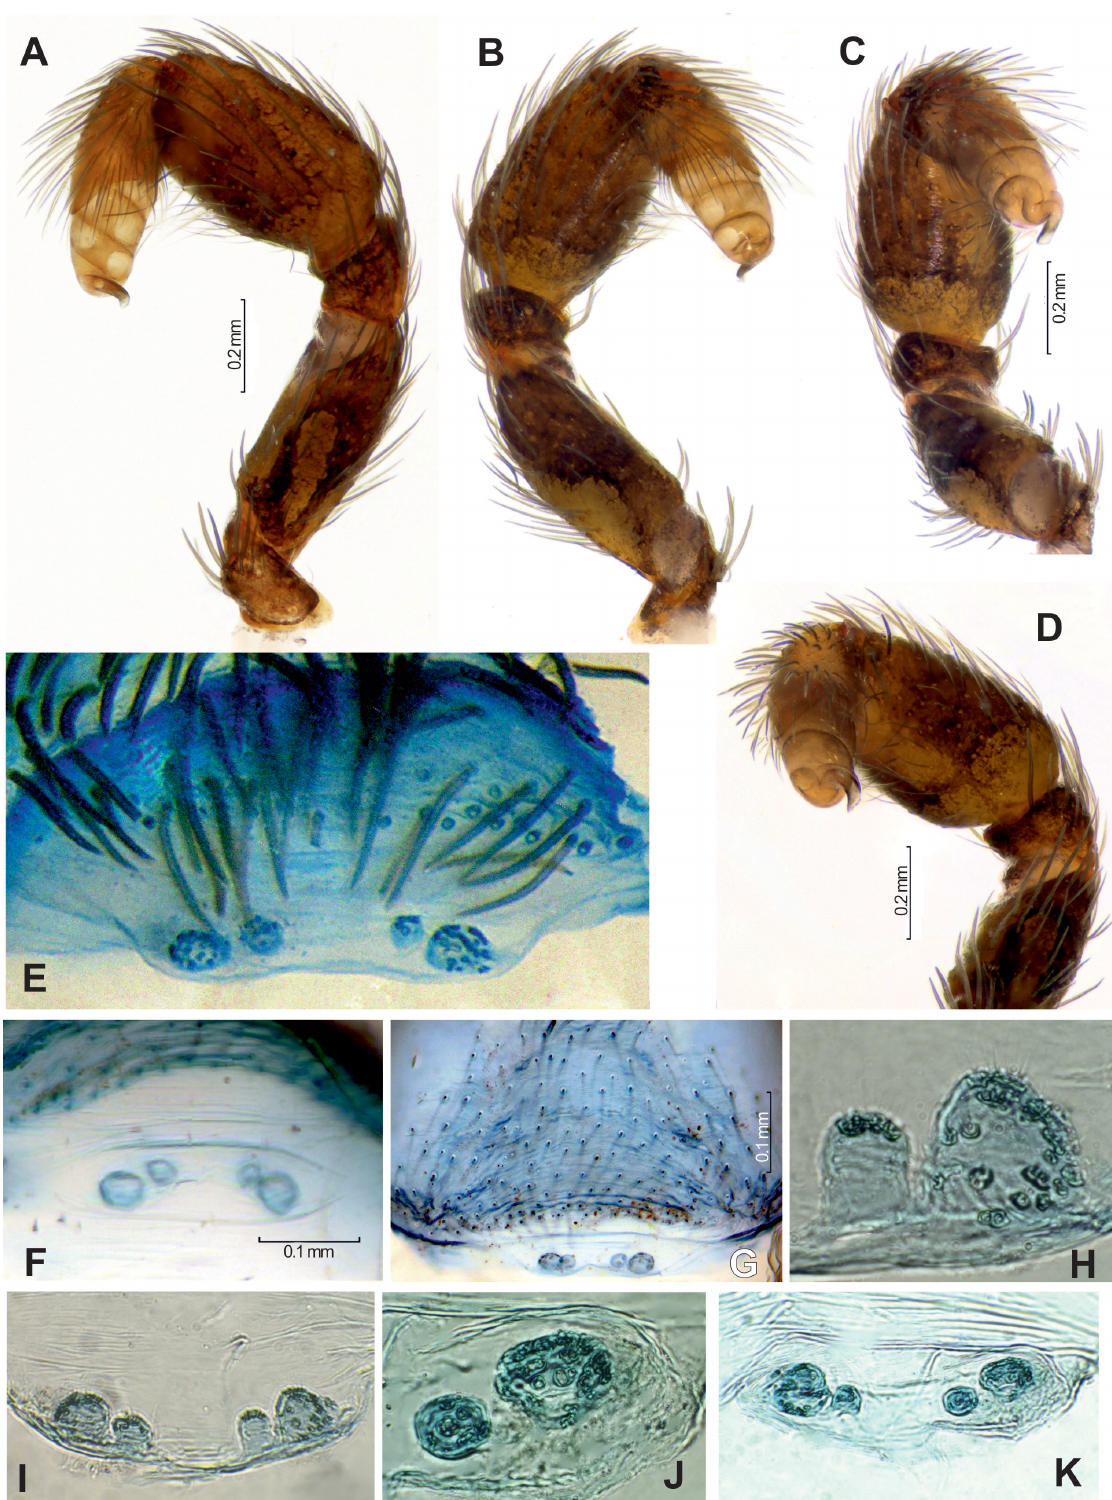
Fig. 7. Copulatory organs of Zaitunia schmitzi (Kulczyński, 1911), ♂ ( A – D ) and ♀ ( E – K ) from Jerusalem area. — A–B . Palp, retrolateral and prolateral. C – D . Same, ventro-prolateral and ventro- retrolateral. E , G , K . endogyne, anterior. F . Same, posterior. H , J . receptacles, dorsal and anterior. I . endogyne,